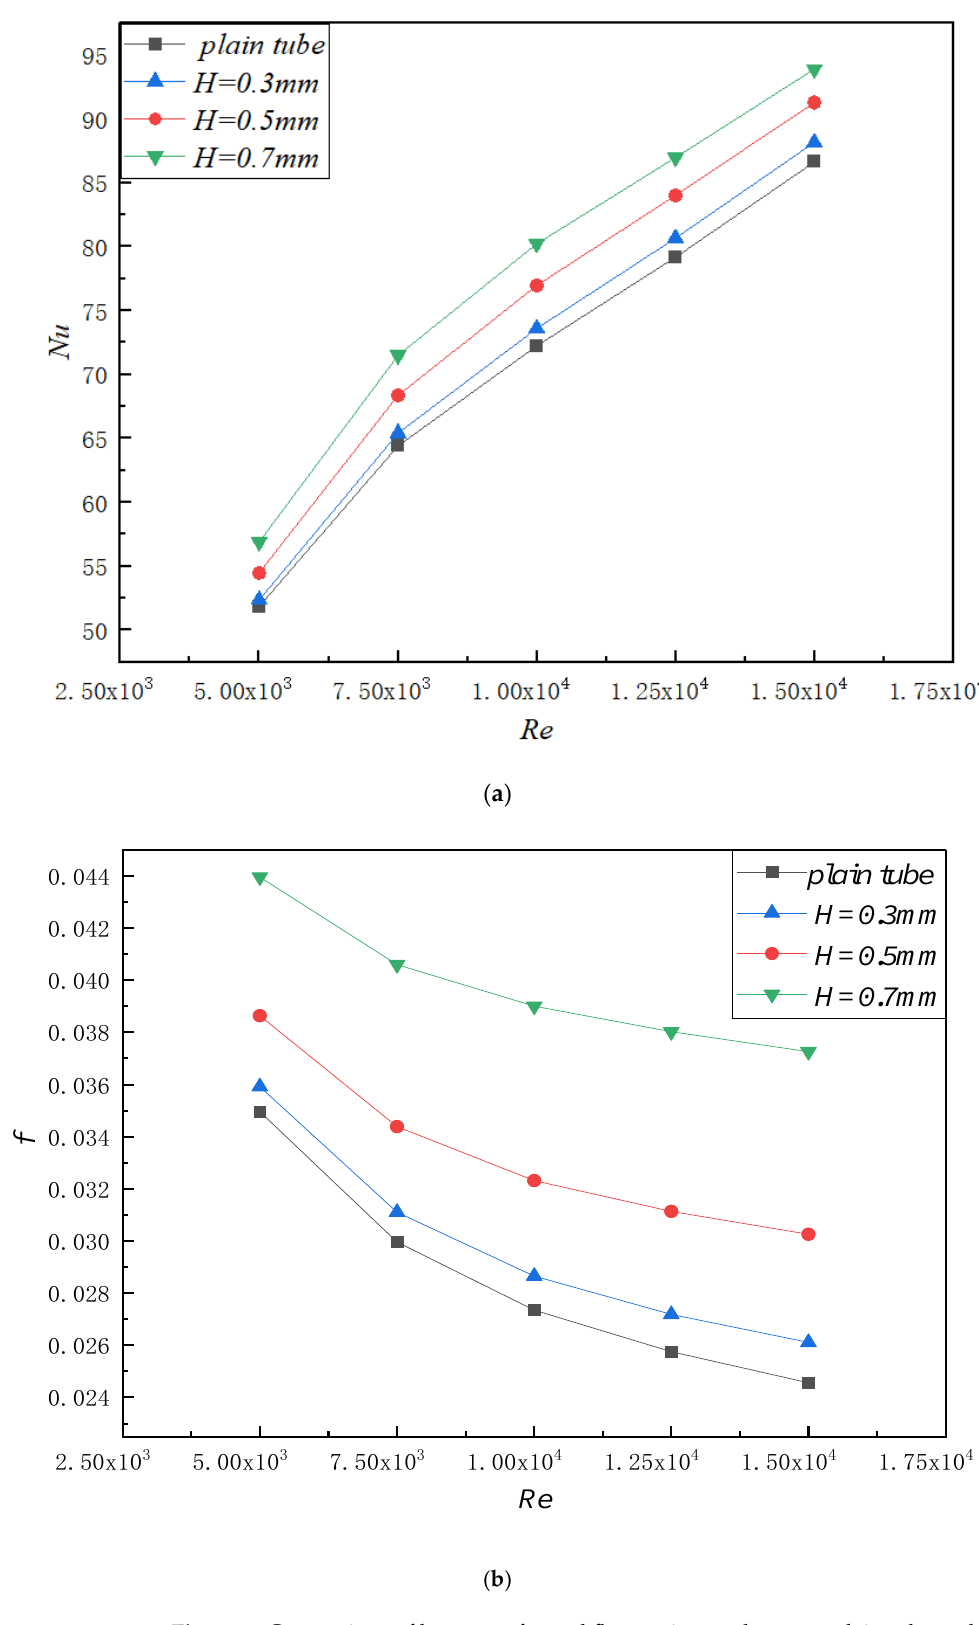
Figure 8. Comparison of heat transfer and flow resistance between plain tube and smooth tube with RWVGs in different H . ( a ) Nu , ( b ) f .